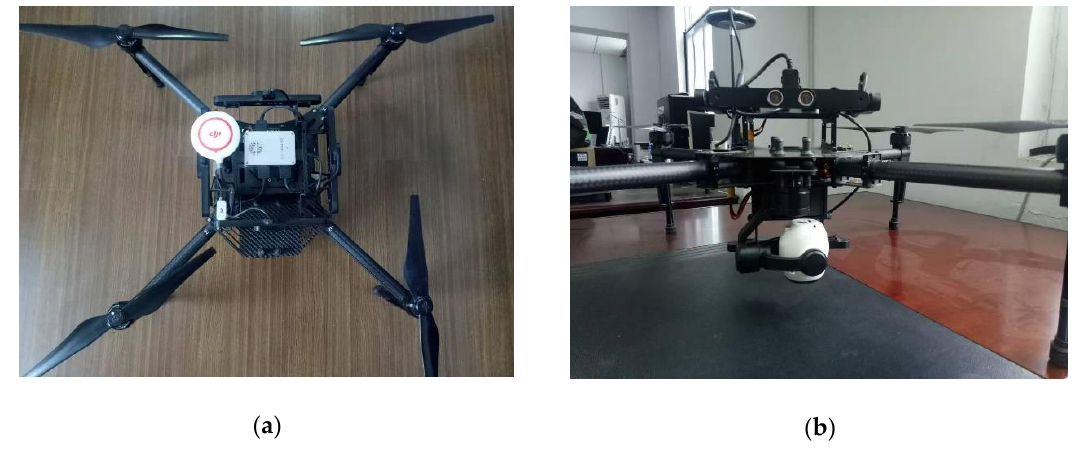
Figure 11. Hardware device. ( a ) Top view; ( b ) side